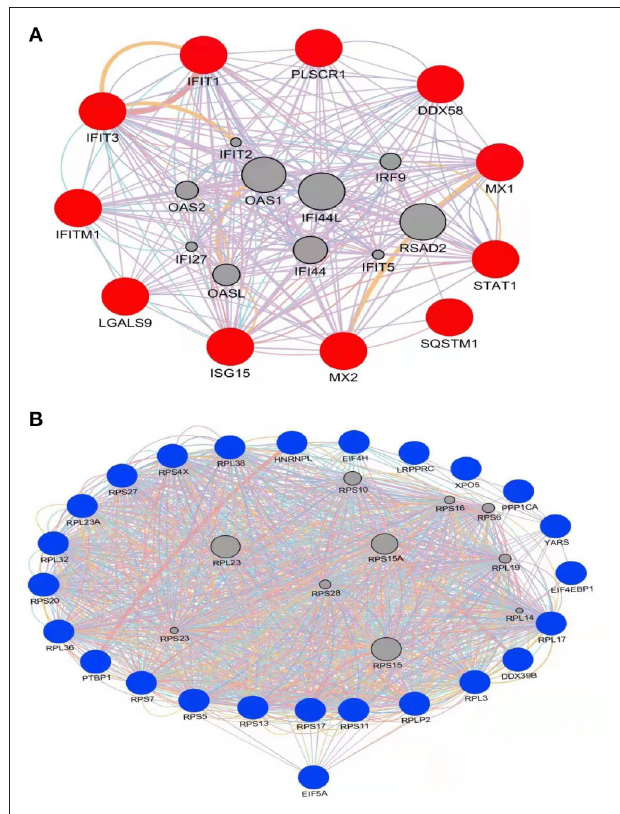
FIGURE 4 | PPI network with significantly differentially expressed proteins in HP-PRRSV infected-PAMs using the GeneMANIA tool. (A) Significantly up-regulated proteins are shown in red; (B) Significantly down-regulated proteins are shown in blue. Edge: interaction between two different